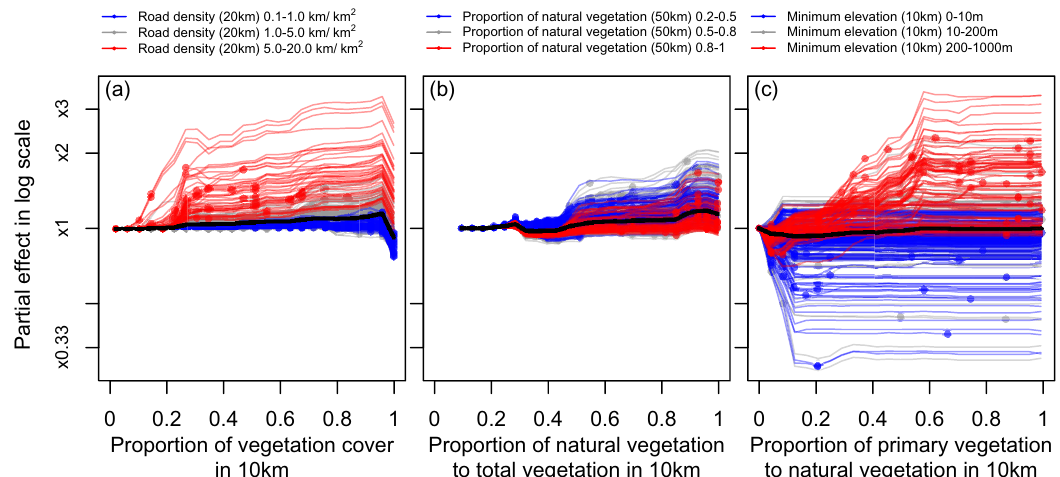
Figure 3. Individual conditional expectation plots for ( a ) Total vegetation cover in 10 km, ( b ) Proportion of natural vegetation to total vegetation cover in 10 km, ( c ) Proportion of primary vegetation to natural vegetation in 10 km. Partial effects of each explanatory variable were shown in log scale. Expected responses for each grid were centered to be zero at the low end of an explanatory variable. The value of a variable whose interaction with a vegetation variable was important was shown by color of a line. Filled circles indicate observed values of a vegetation variable for each site. A black line indicates an average effect. Five hundred sites were randomly sampled for visualization to avoid the plots being too